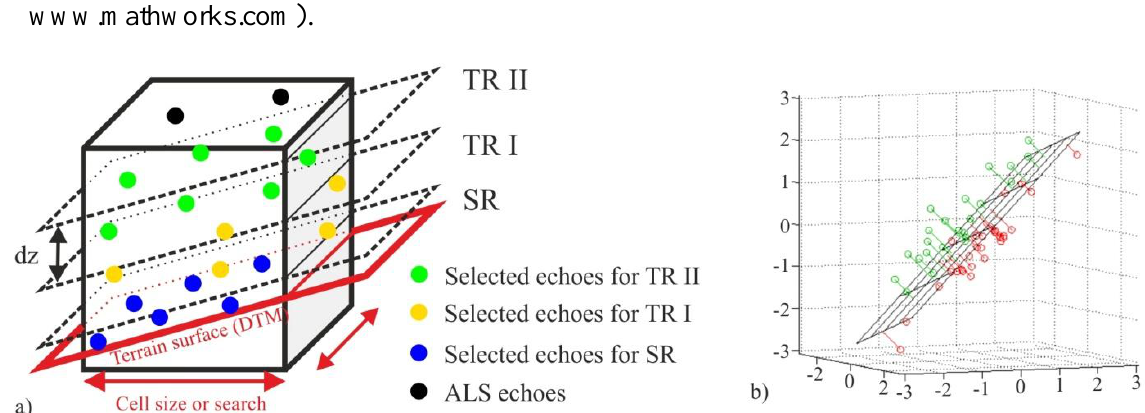
Figure 3. Schematic representation of roughness calculation using ALS data. (a) Predefined cube or cylinder for selecting terrain or off-terrain echoes used for plane fitting. (b) Principle of orthogonal regression plane fitting (modified